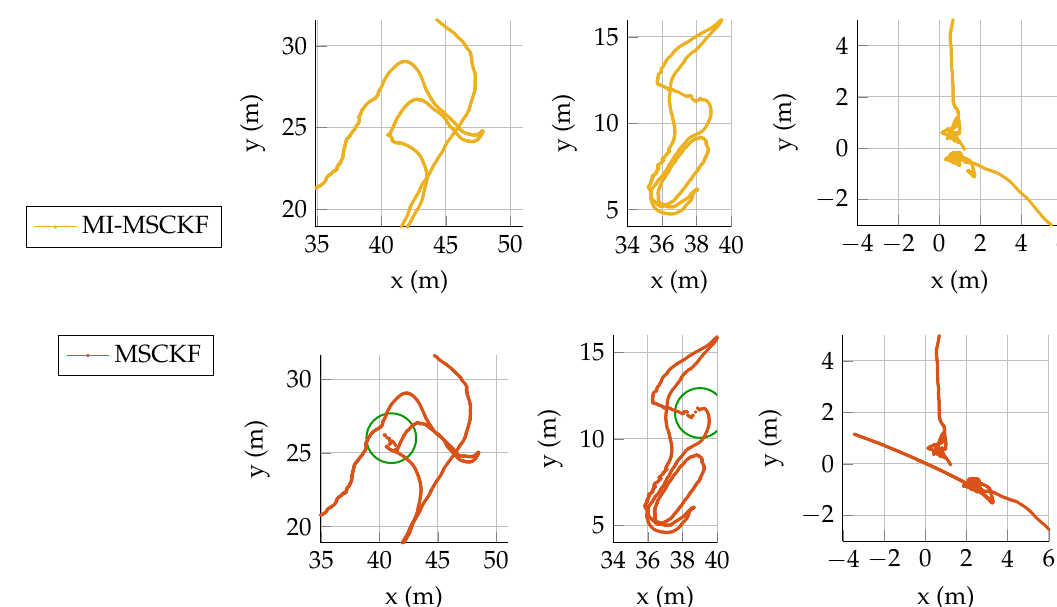
Figure 7. Details of estimation results on Traj2 showing a different behavior between the MSCKF and MI-MSCKF filter. Left and middle plots : while transitioning from dark area to lit environment some strong filter correction happen for the MSCKF and lead to discontinuities of the position estimate. In the same areas, MI-MSCKF stays smoother. Right plot : here the device is laid on the ground at the end of the trajectory. A large drift of MSCKF occurs, as visual information does not provide any feedback on position. Here again, the MI-MSCKF appears more